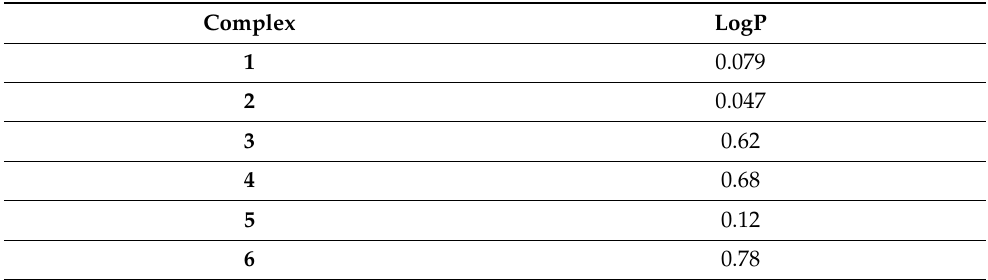
Table 2. Measured LogP values for NHC-Au(I) complexes.